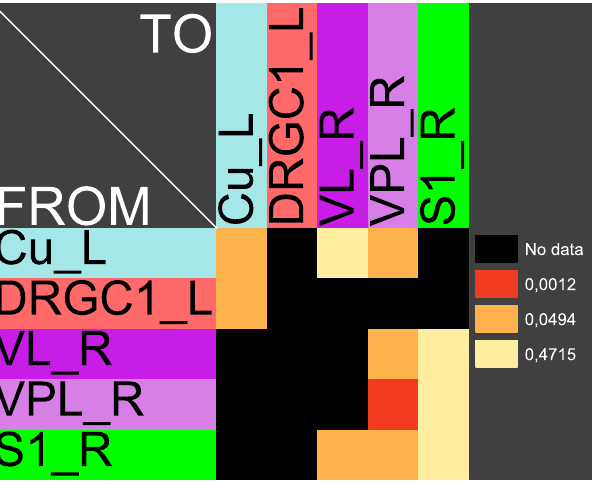
Fig 22. Adjacency matrix. Adjacency matrix of mechanosensitive subnetwork.